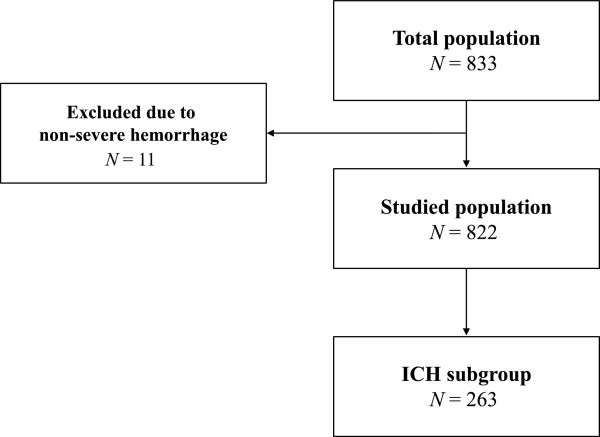
Study flow chart.